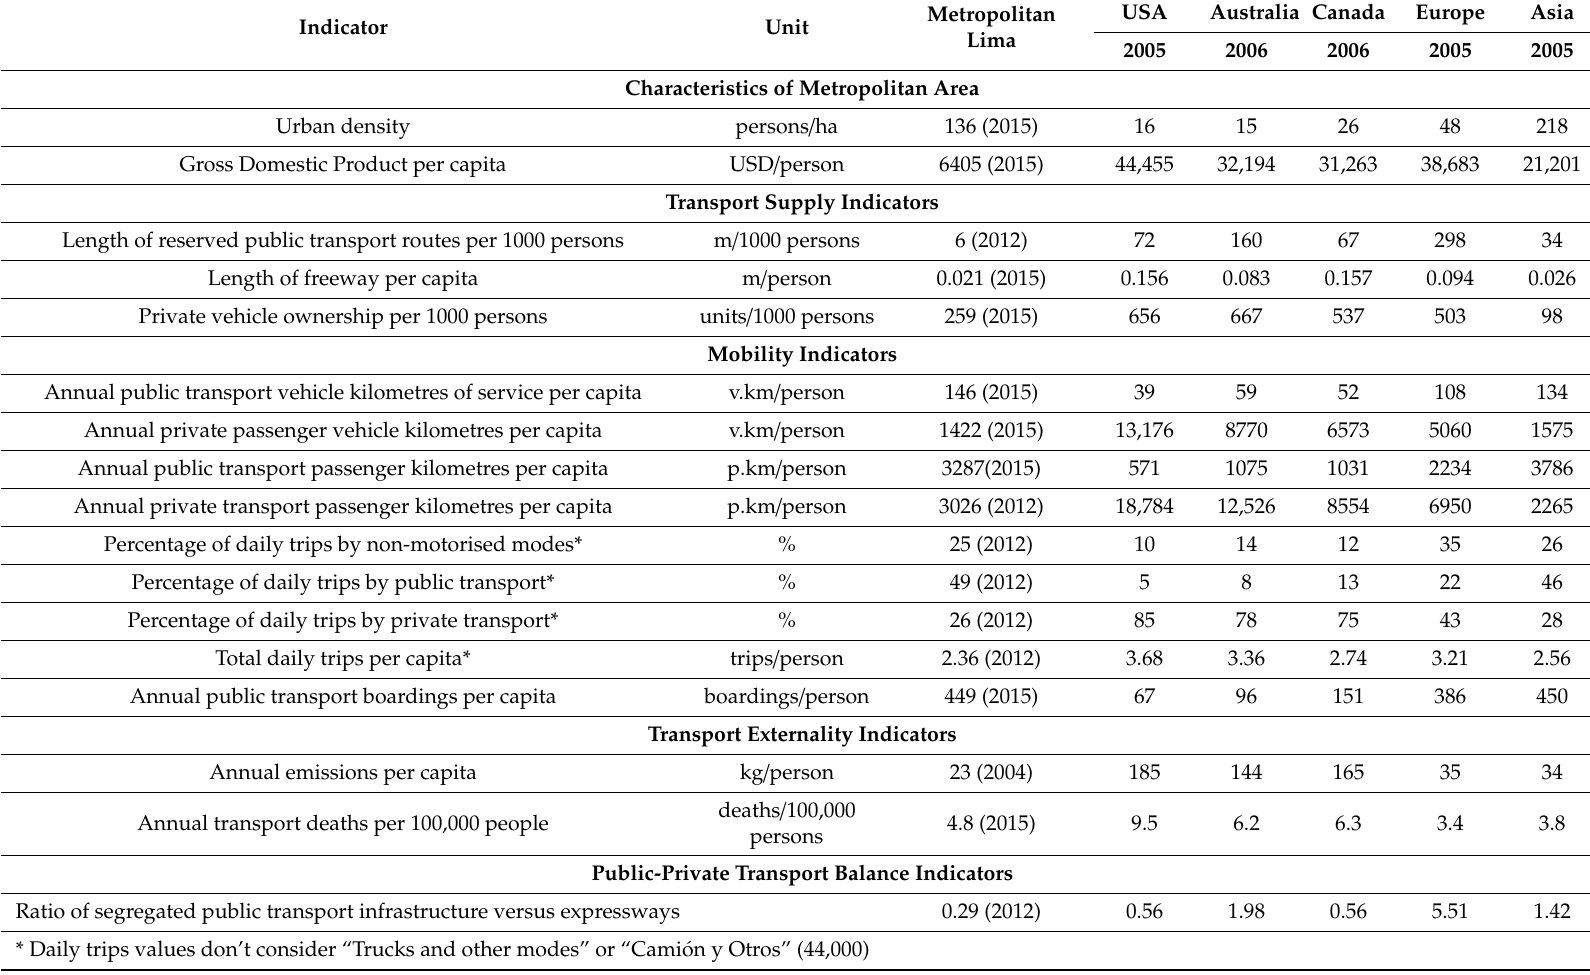
Table 4. Key comparative urban data for Lima and averages for other groups of world